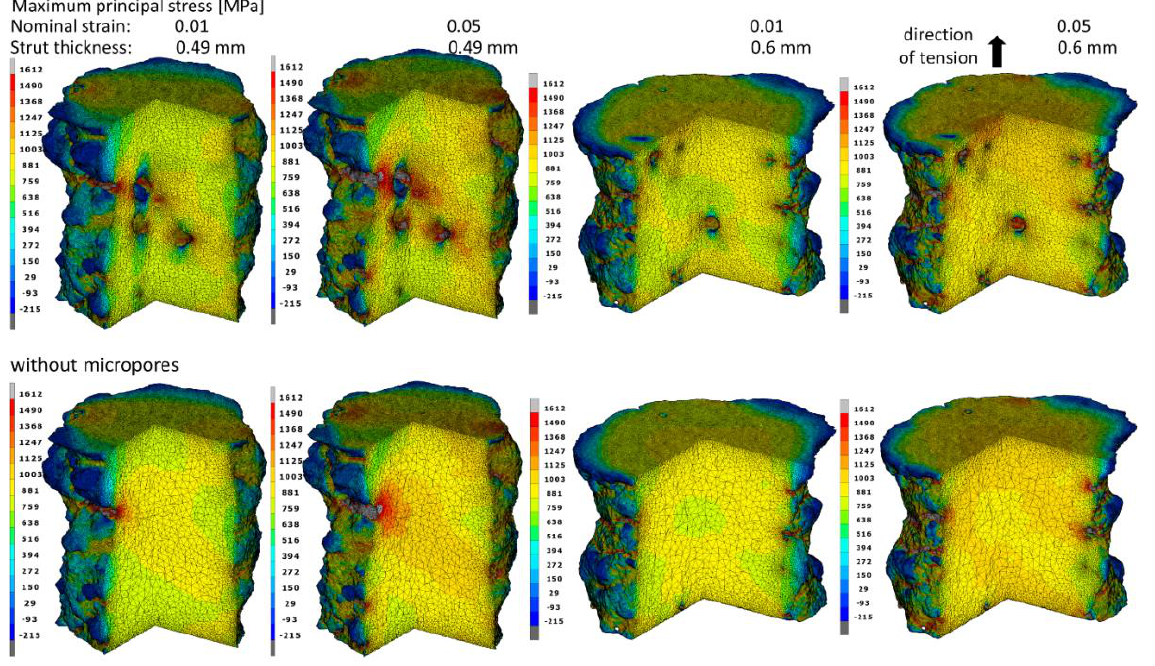
Figure 9. Maximum principal stress fields in the struts with and without micropores at the moment of obtaining the nominal strains of 0.01 and 0.05.